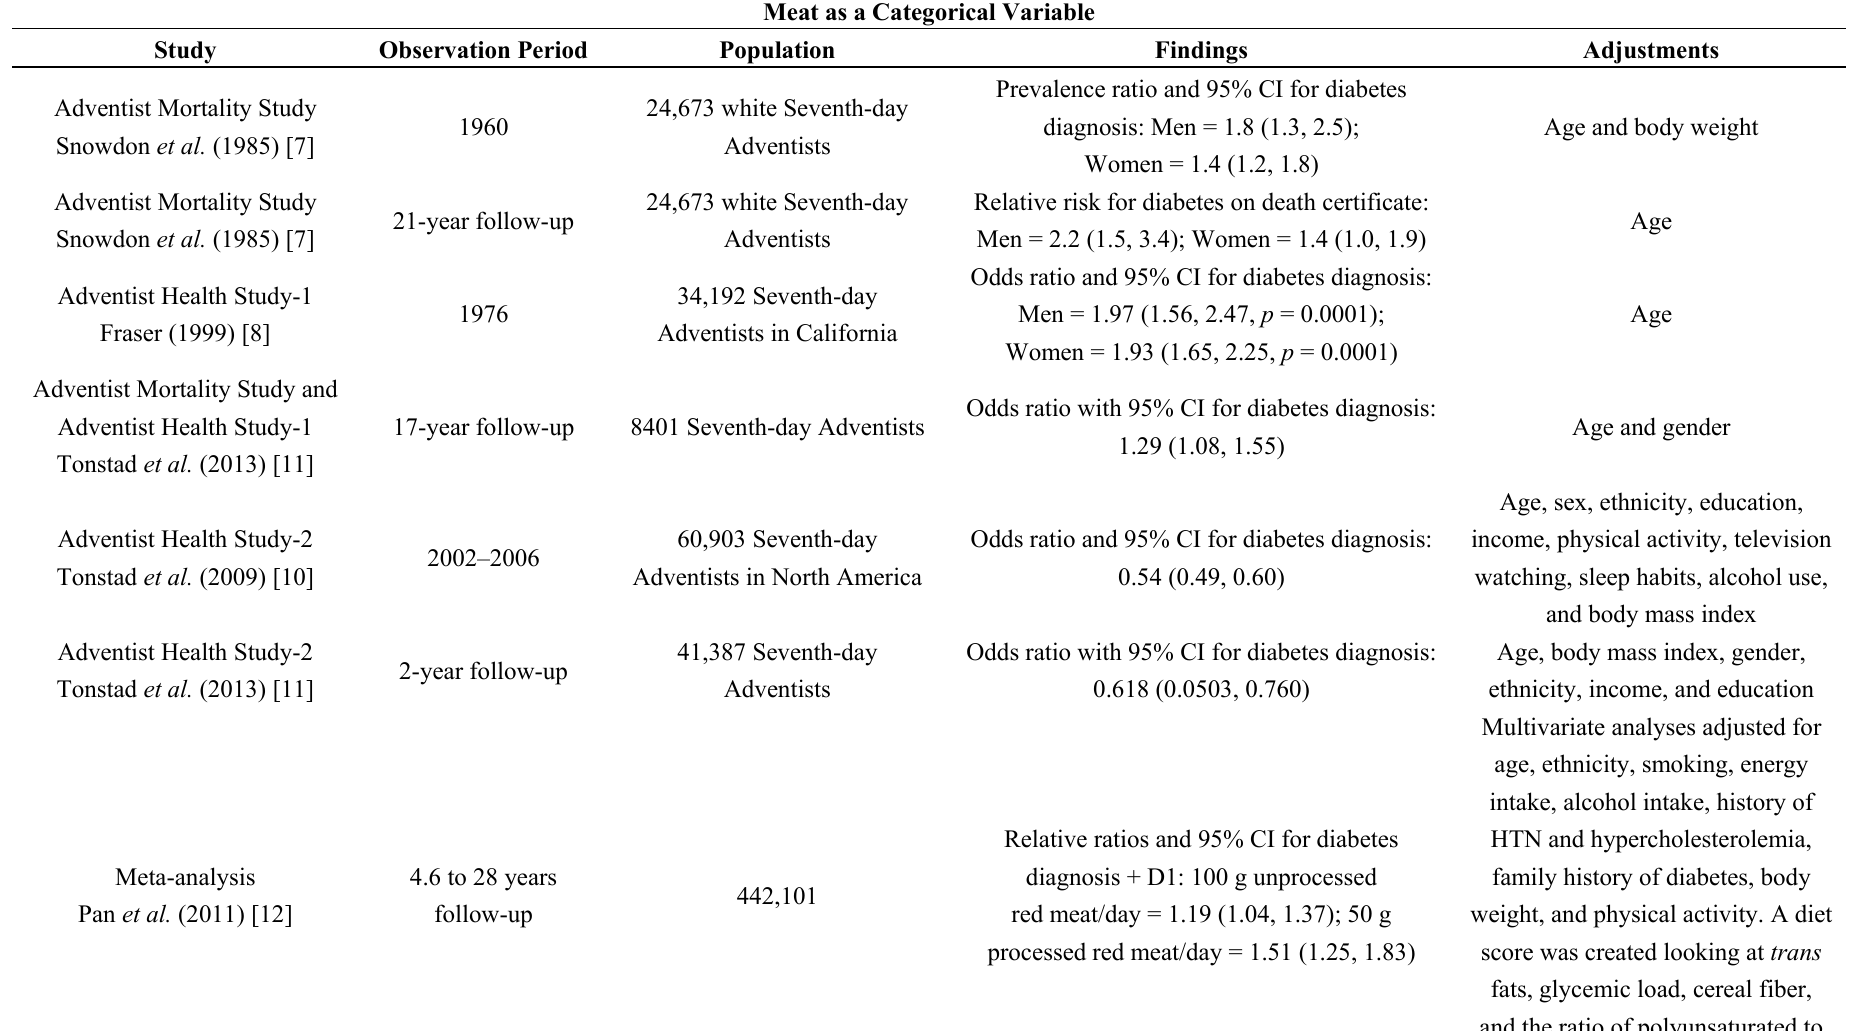
Table 1. Published studies of the relationship between meat consumption and risk of type 2